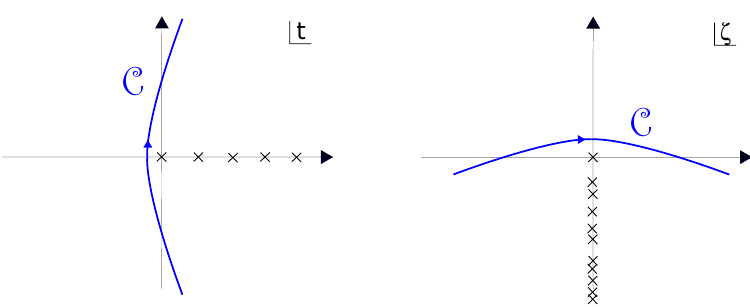
Figure 4 . Left: contour C used to define I α ( x ) . Right: contour C used to define the q -deformed version I (cid:15) ( x ) α